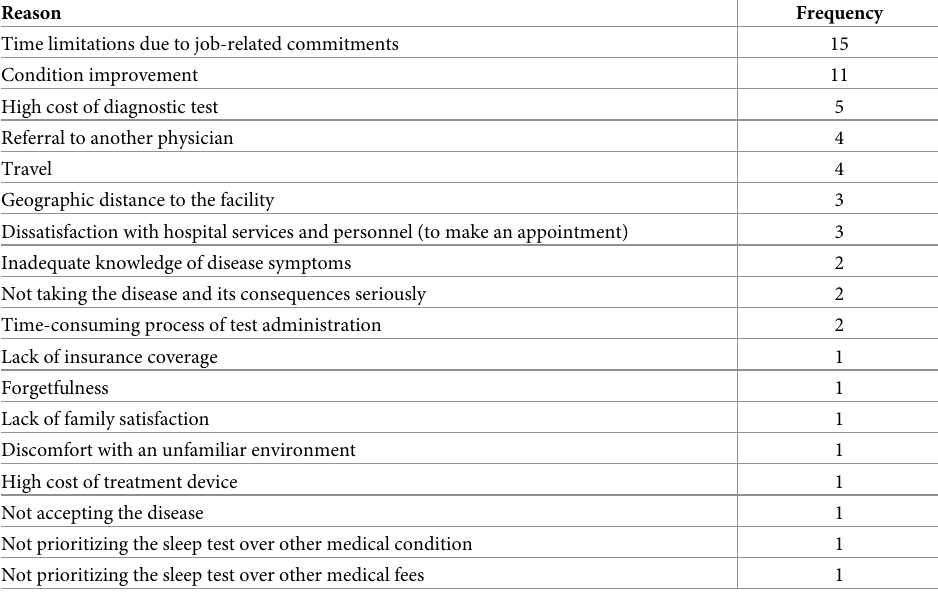
Table 4. Reasons of patients in intervention group for not adhering to physician’s prescription of sleep test. Reason Frequency Time limitations due to job-related commitments 15 Condition improvement 11 High cost of diagnostic test Referral to another physician Travel 4 Geographic distance to the facility 3 Dissatisfaction with hospital services and personnel (to make an appointment) 3 Inadequate knowledge of disease symptoms 2 Not taking the disease and its consequences seriously 2 Time-consuming process of test administration 2 Lack of insurance coverage 1 Forgetfulness 1 Lack of family satisfaction 1 Discomfort with an unfamiliar environment 1 High cost of treatment device 1 Not accepting the disease 1 Not prioritizing the sleep test over other medical condition 1 Not prioritizing the sleep test over other medical